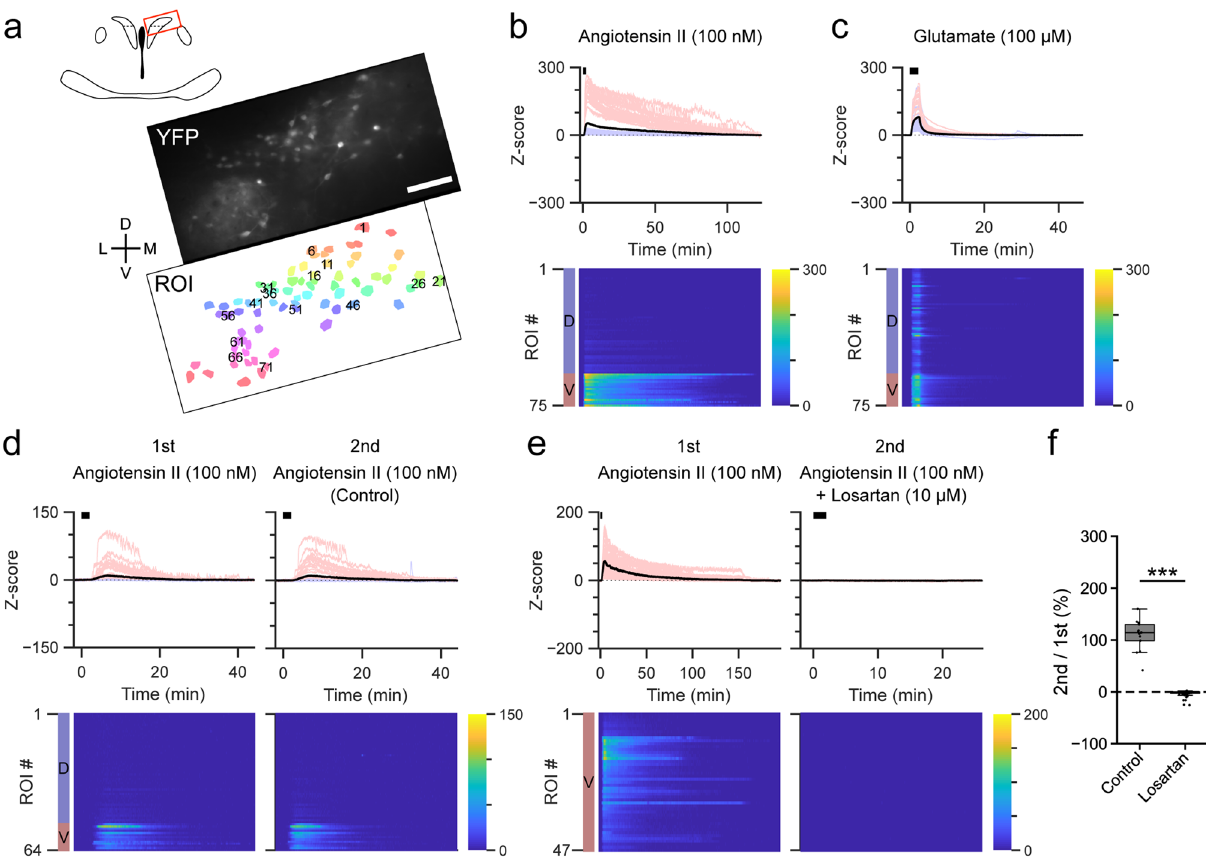
Figure 3. Effect of angiotensin II on PVN-CRF neurons. ( a ) YFP signal (upper) and regions of interest (ROIs, lower) of a representative brain slice. The brain region is indicated by the red box in the upper illustration. Numbers superimposed over the ROIs align with the dorsoventral axis (from dorsal to ventral). D dorsal, V ventral, L lateral, M medial; scale bar: 100 μm. ( b – e ) Z-scores of the YFP/CFP ratio recorded from each representative brain slice, ( b ) and ( c ) are from the brain slice shown in ( a ). Upper graphs show traces of individual ROIs (light blue: dorsal PVN, light red: ventral PVN) and mean value (black). Black bars indicate the application timing (2 min) of each substance, angiotensin II (AngII) in ( b ), ( d ) and ( e ), glutamate in ( c ). Heat maps show the Z-scores of individual ROIs indicated by the color bars at right. Blue and red color bars at left indicate the dorsal (D) and ventral (V) PVN. AngII was applied twice in ( d ) and ( e ). The type-1 AngII receptor- selective antagonist losartan was applied 5 min before the second application of AngII in ( e ). ( f ) Box plots of ratio of the area under the curve of the Z-scores for the ventral PVN between the first and second application of AngII with and without antagonist. Dots show individual data. ***p < 0.001, Mann–Whitney U